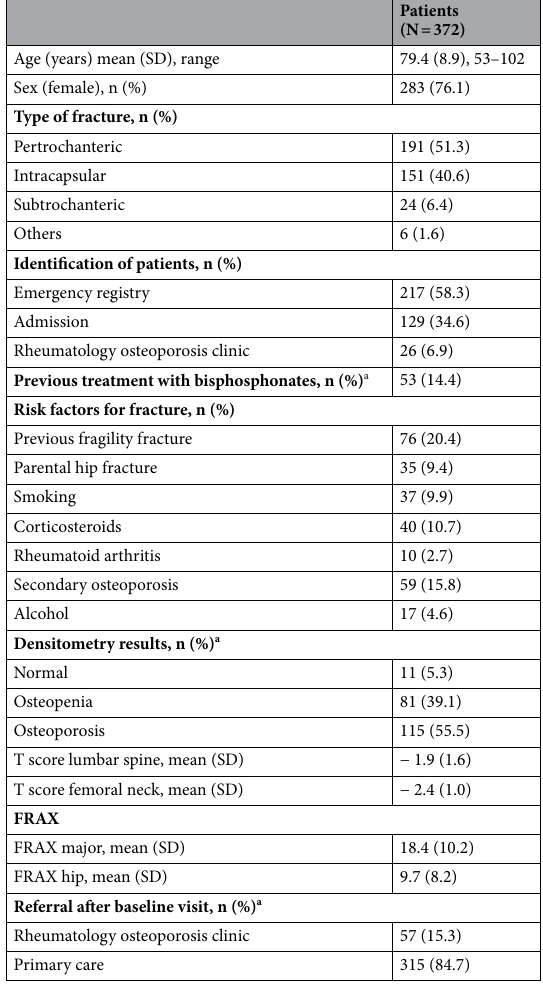
Table 1. Baseline characteristics of patients. a Previous treatment recorded in 369 patients. Densitometry values were recorded in 207